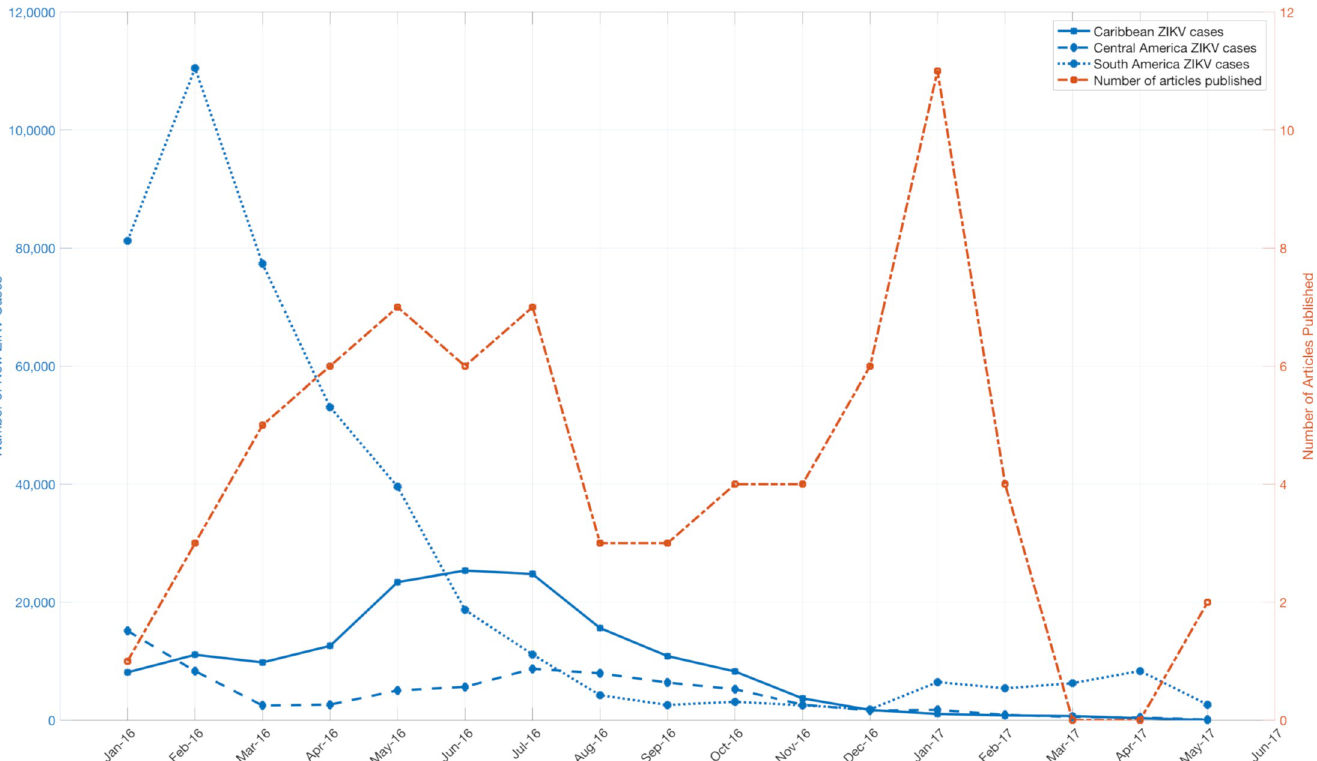
Fig 2. Comparative trends of reported Zika cases in Latin American and publication times of Zika prediction studies. Zika case counts were obtained from https:// andersen-lab.com/ with permission.